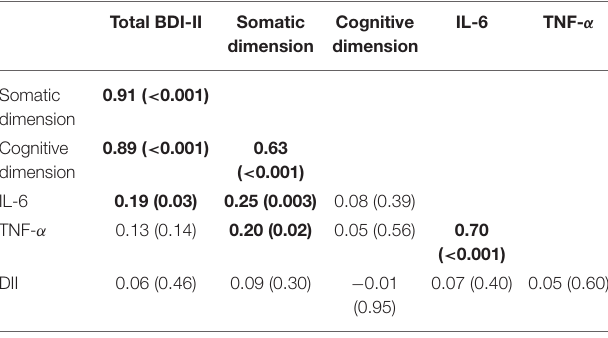
TABLE 2 | Bivariate correlations of depression, cytokines, and